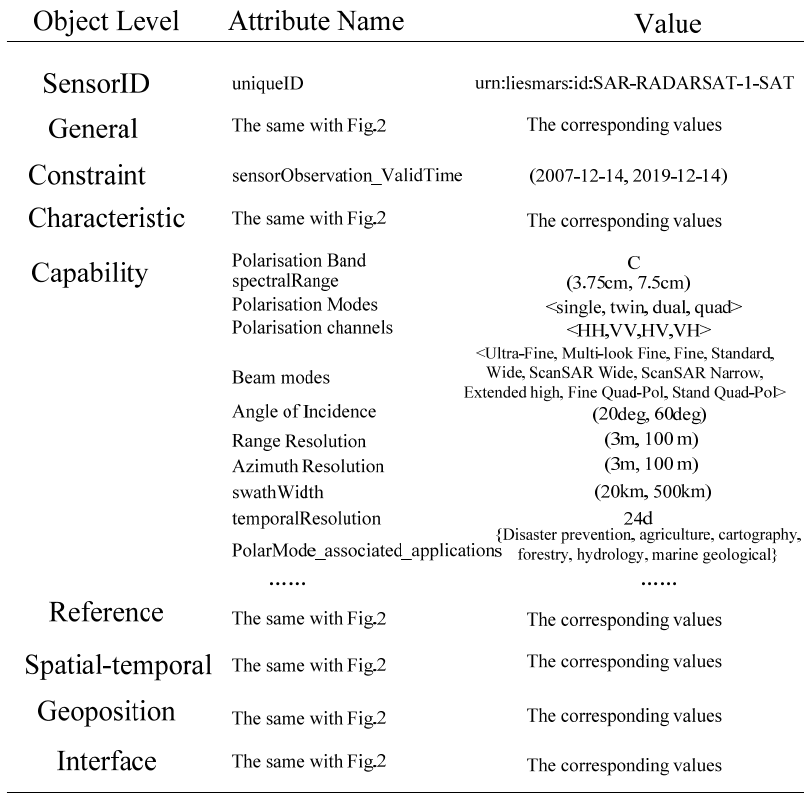
Figure 4. The assignment of meta-attribute values for RADARSAT-2_SAR